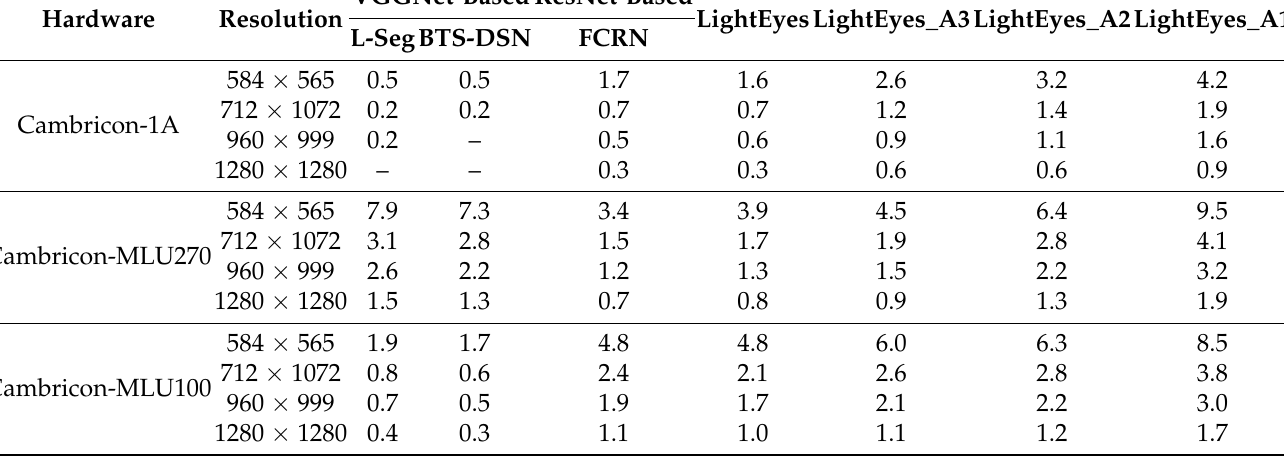
Table 11. Fps of the LightEyes and other models on Cambricon-1A and